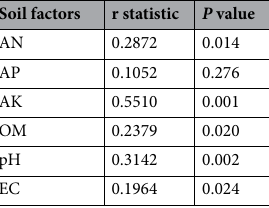
Table 3. The correlations (r) and significance ( P value) determined by Mantel test between the bacterial community composition and soil factors.